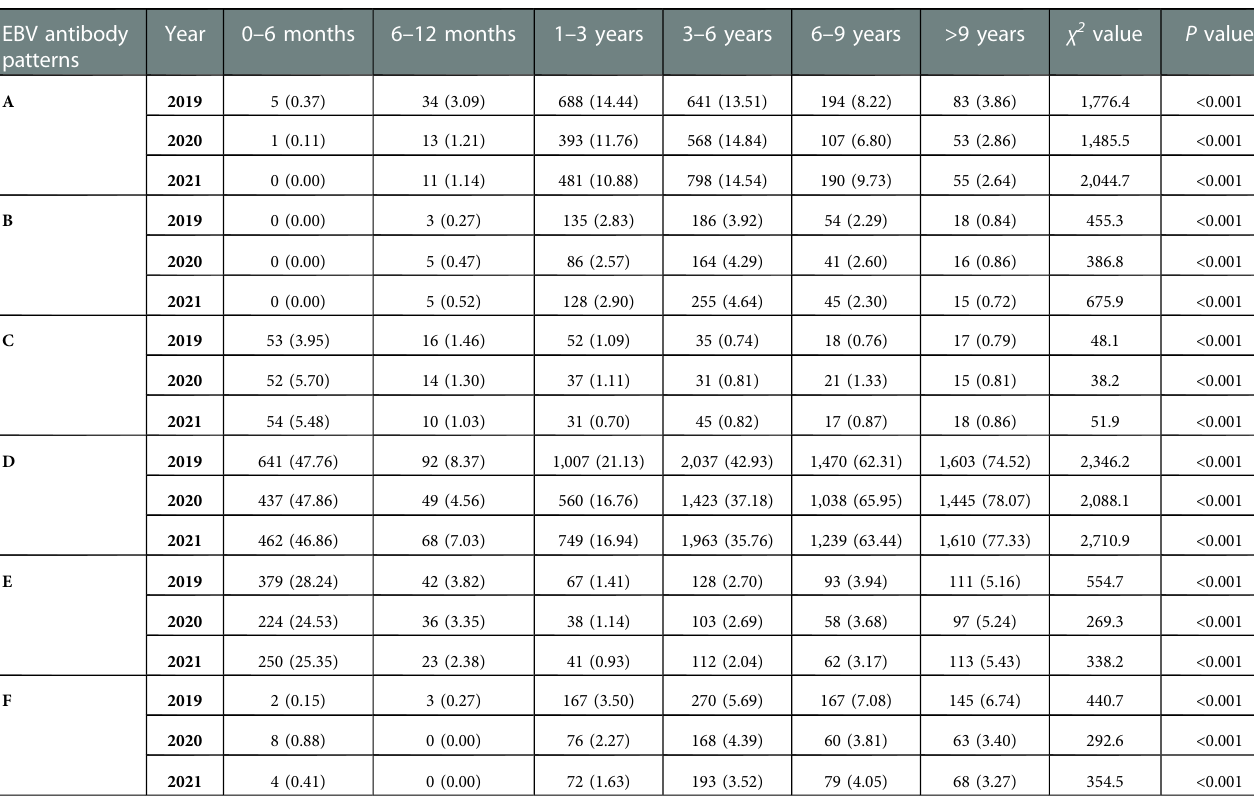
TABLE 4 Detection of different EBV antibody patterns based on age between January 2019 and December 2021. EBV antibody